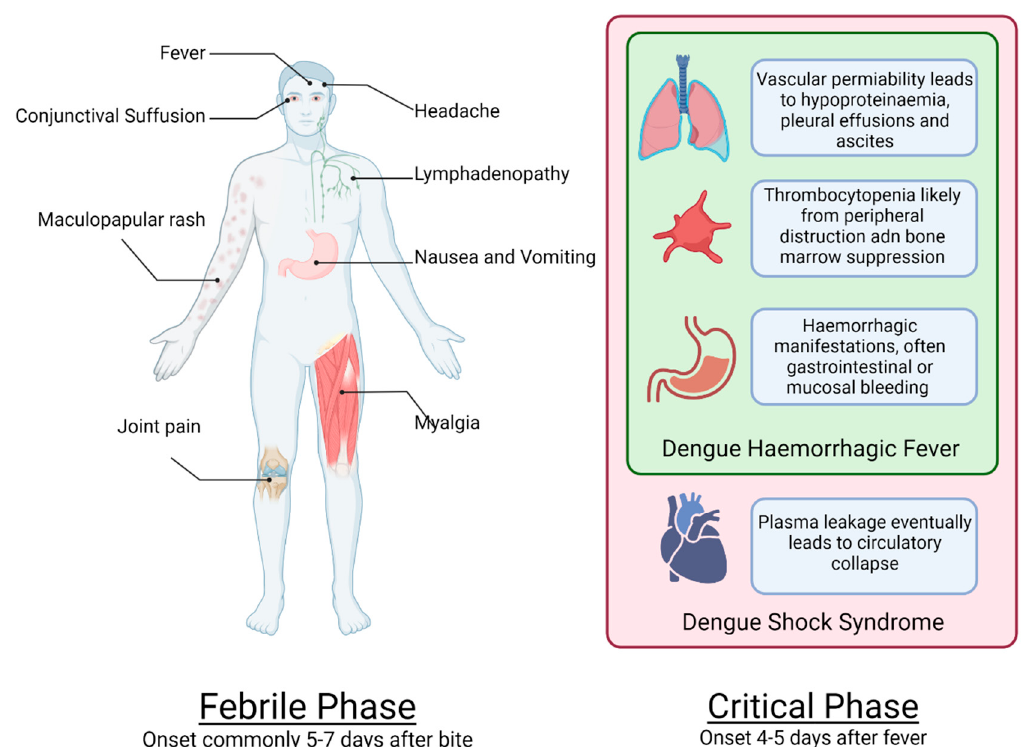
Figure 1. Systemic effects of dengue and time course of infection.